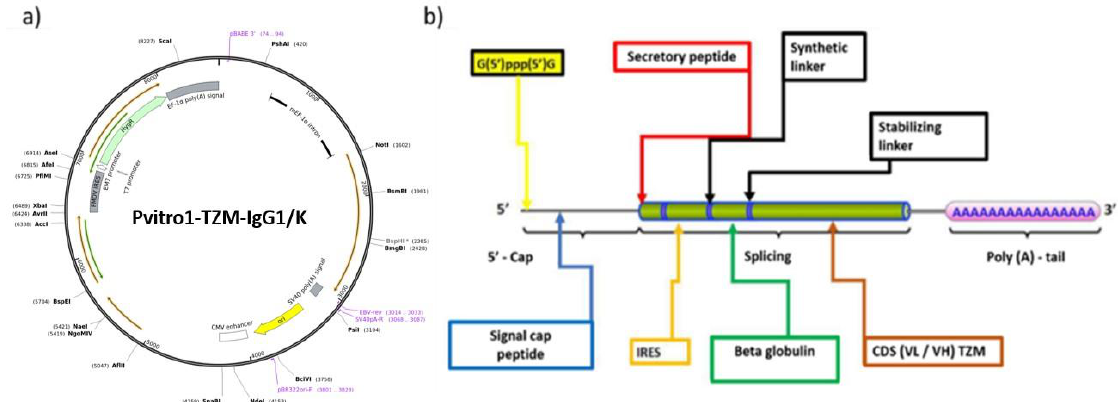
Figure 5. (a) Plasmid preparation backbone; (b) mRNA optimization chart showing the additions and mutations utilized Figure 5. ( a ) Plasmid preparation backbone; ( b ) mRNA optimization chart showing the additions and mutations utilized for our clinical experiment. for our clinical experiment.